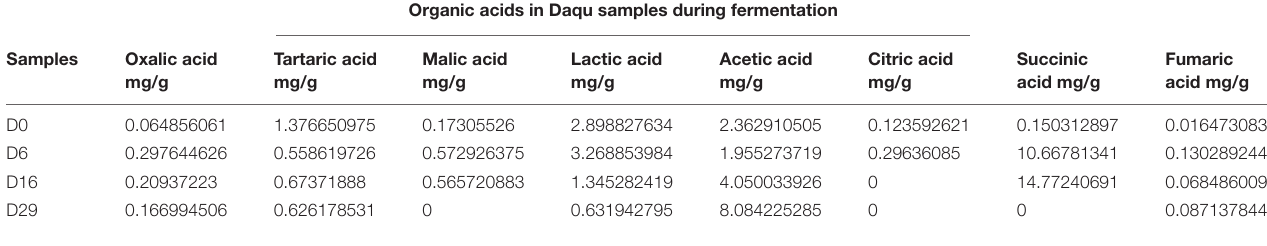
TABLE 1 | α -diversity indices for microbial communities among samples.